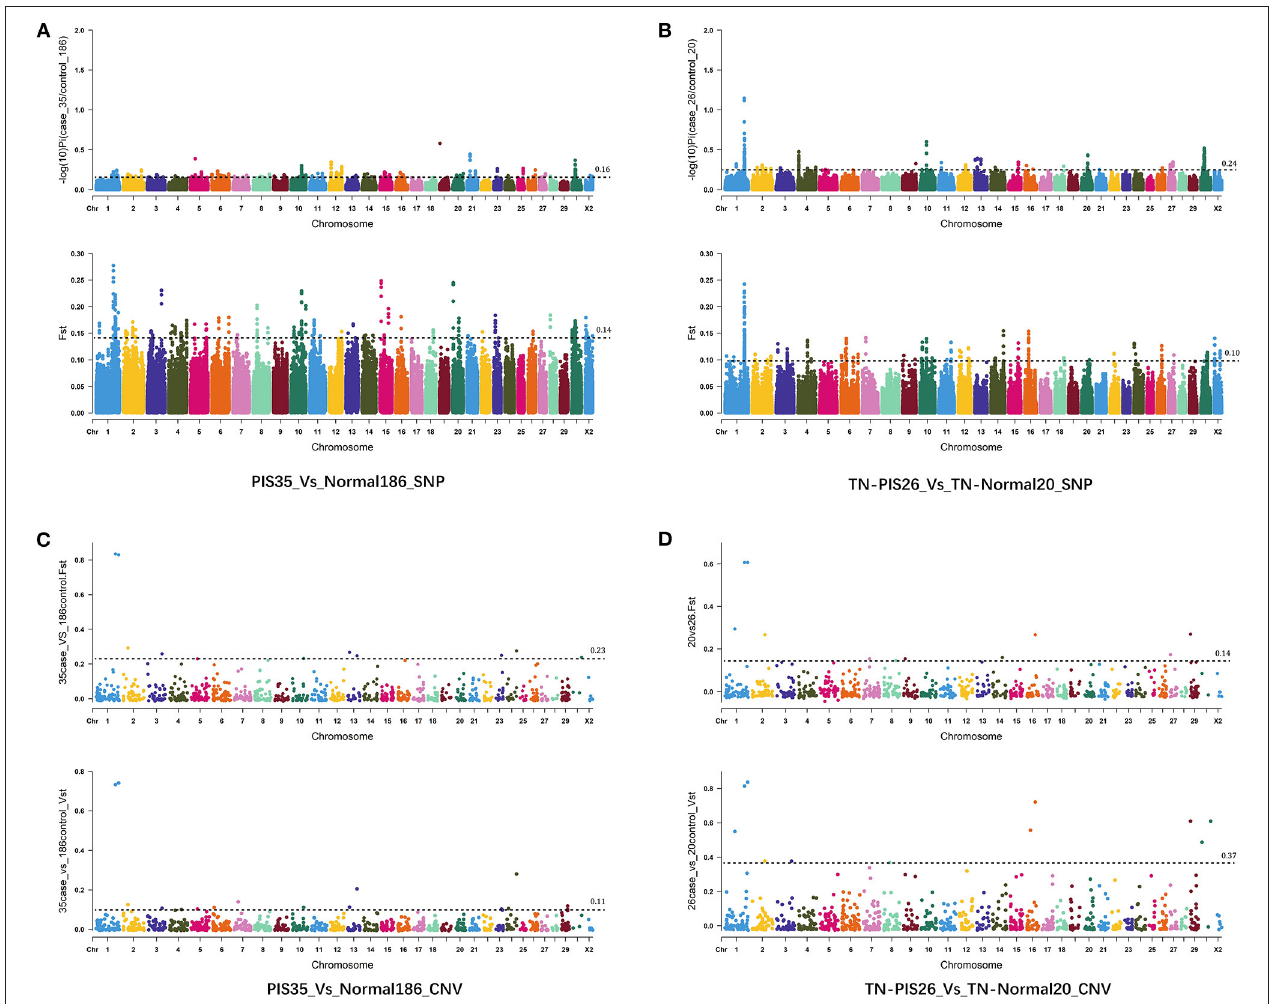
FIGURE 1 | Genome-wide selective sweep of goat intersexuality by using SNPs and CNVs. (A) Manhattan plot showing the SNP-based selection signals of 35 intersex goats compared with those of 186 non-intersex goats from a large geographically distributed population. (B) Manhattan plot showing the SNP-based selection signal of intersex goats within the Tangshan dairy goat population. (C) Manhattan plot showing the CNV-based selection signals of 35 intersex goats compared with those of 186 non-intersex goats from a large geographically distributed population. (D) Manhattan plot showing the CNV-based selection signals of intersex goats within the Tangshan dairy goat